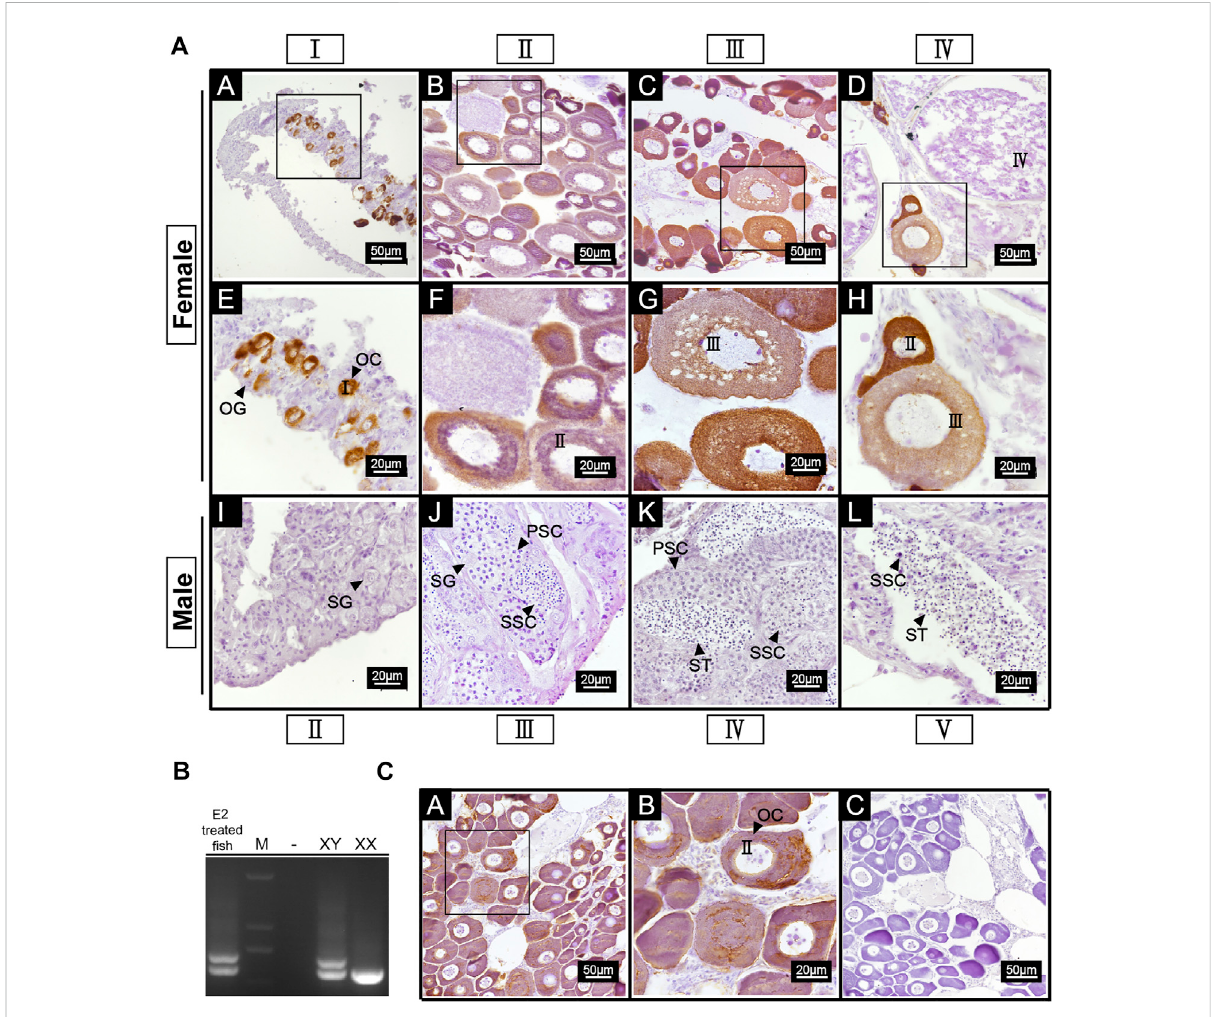
Cellular location of 42Sp50 in gonad of spotted scat by IHC. (A) A – H are ovaries at stage I, II, III and IV, respectively. E – H are the high magni fi cations of the boxed areas in A – D, respectively. I – L are testes at stage II, III, IV and V, respectively. (B) The identi fi cation of genetic sex